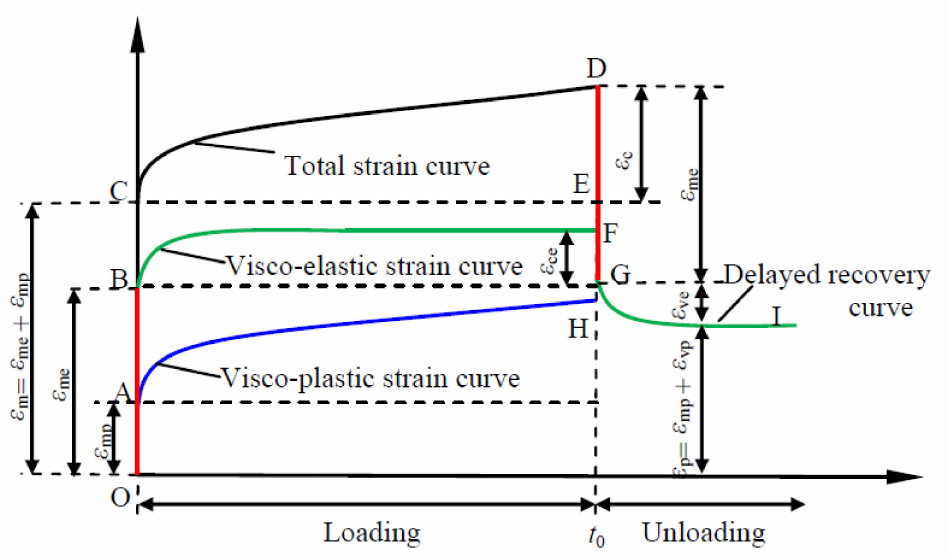
Figure 6. Representative strain-time curve defining different types of strains